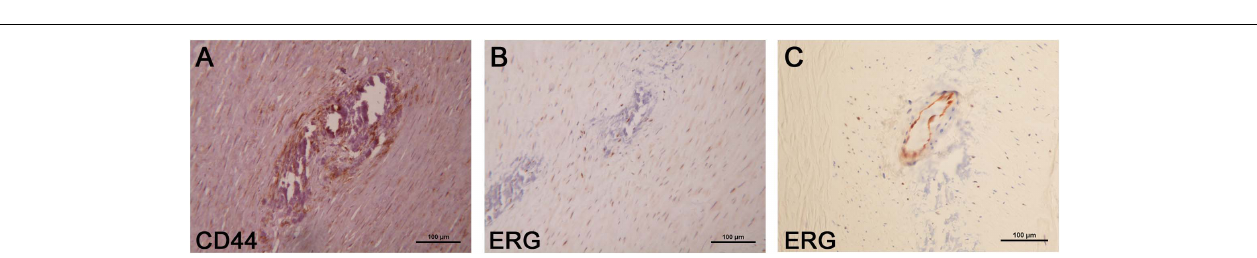
FIGURE 4 | Additional immunohistochemical analysis of the areas of calcification showed CD44 (A) and ERG (B) positivity within and at the periphery of the calcifications where these markers were expressed by mesenchymal spindle cells; ERG was also positive in the endothelial cells that line the newly formed vessels present within the calcifications (C) . Scale bar of all images = 100 µ